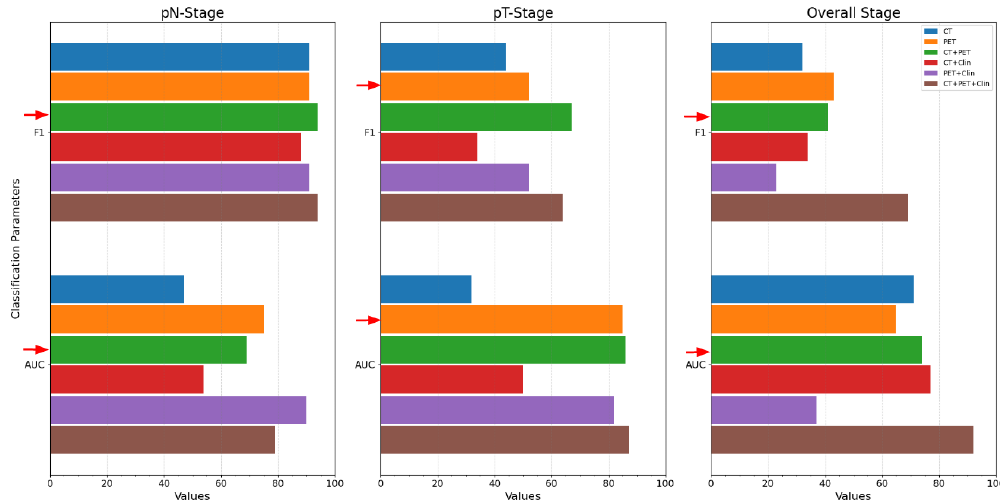
Figure 6. Radiomics features extracted from the wavelet-filtered PET and CT images. The bar-plot refers to all possible combinations between the features, to obtain higher classification performance (F1 score and AUC), relative to pN-Stage (18 features from CT images and 23 features from PET images), pT-Stage (18 features from PET images) and the Overall Stage (22 features from CT images and 11 features from PET